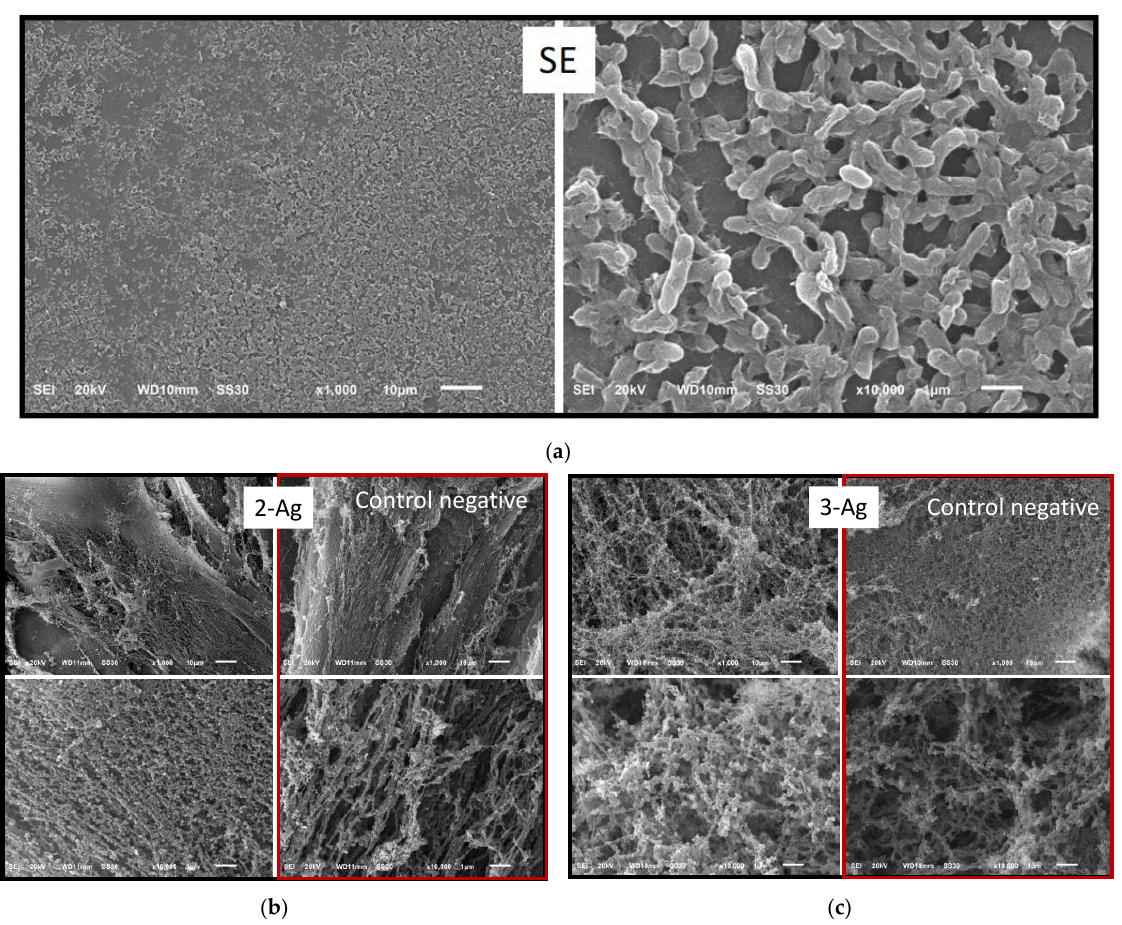
Figure 11. SEM of bacterial samples after incubation with and without treatment with colloidal solutions and control negative solutions (without bacteria) to observe differences in morphology: ( a ) control SE samples without treatment, ( b ) SE and control negative (highlighted in red) treated with CS/TA/AgNPs (2-Ag) and ( c ) SE and control negative (highlighted in red) treated with CS/GA/TA/AgNPs (3-Ag).